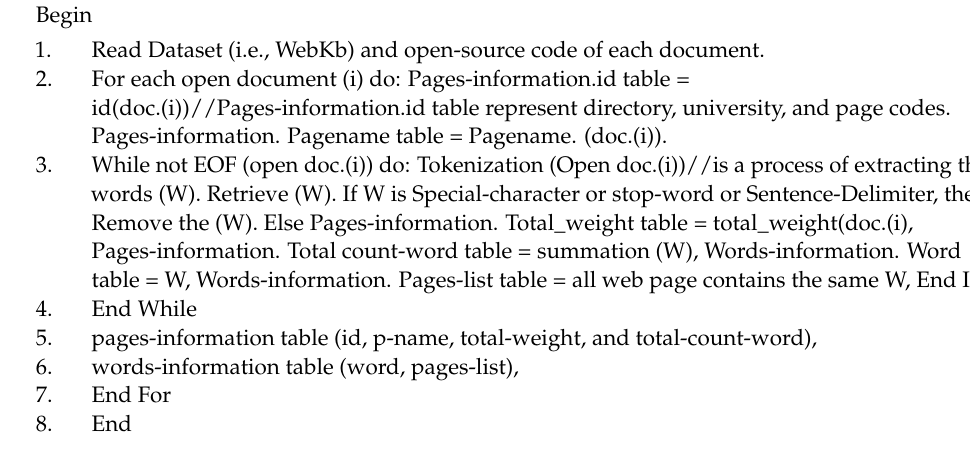
Algorithm 1: Advanced Document Indexing